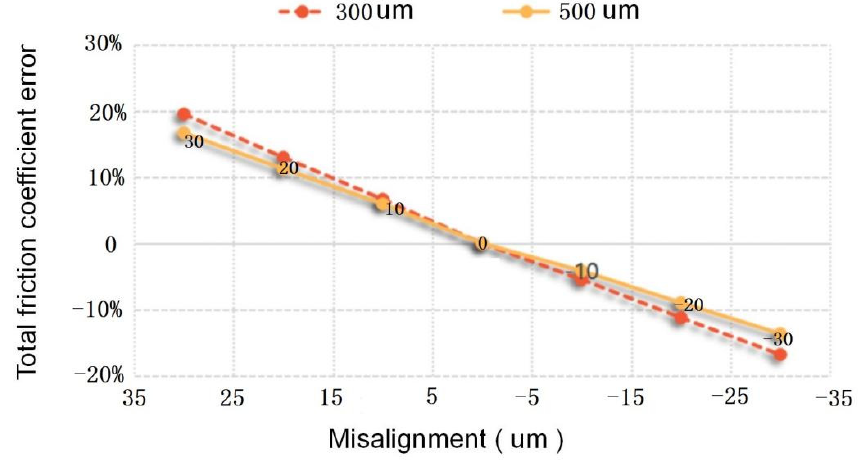
Figure 8. Influence of different misalignment on friction measurement error in laminar low.